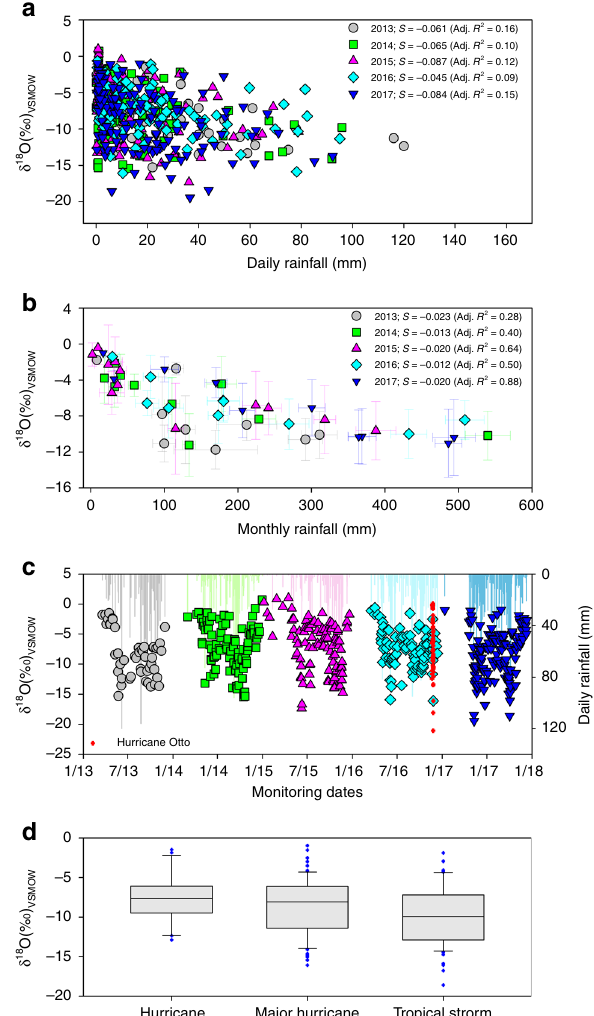
Fig. 7 Amount effect and rainfall δ 18 O ( ‰ ) time series in central Costa Rica during 2013 – 2017. a Daily mean δ 18 O ( ‰ ) versus rainfall amount (mm). b Monthly mean δ 18 O ( ‰ ) versus rainfall amount (mm). Amount effect slopes (S) and adjusted R 2 (Adj. R 2 ) are included for each year. c Daily rainfall δ 18 O ( ‰ ) variability during 2013 – 2017 and Hurricane Otto ’ s isotopic values (red crosses). Color-coded bars denote daily rainfall in mm. d Box-plots of isotope composition in Costa Rica under the